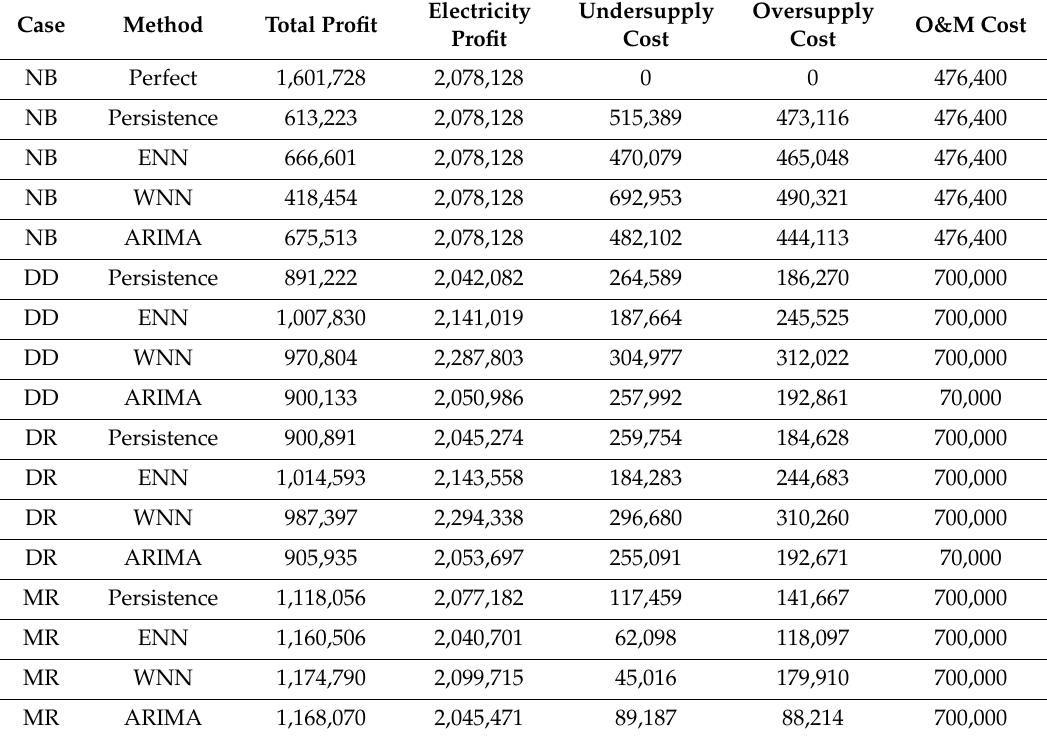
Table 6. The Comparison of Optimisation Results when ρ US = ρ OS = 1 (Units: